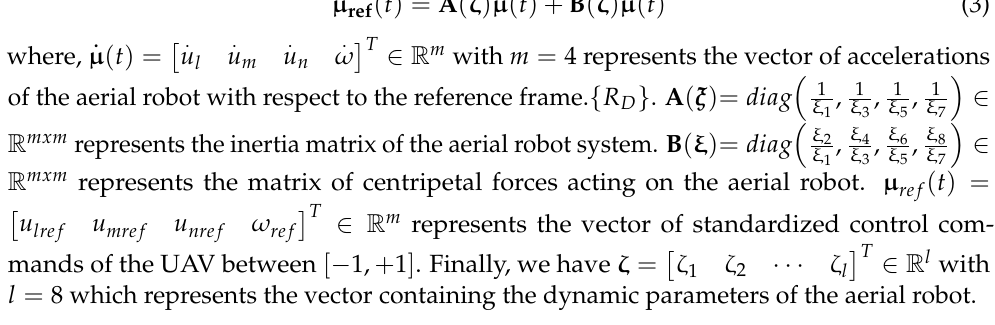
Figure 4. Identification of dynamic parameters. ( a ) Identification scheme; ( b ) Identification data sig- nals. (iii) Validation, the final stage allows us to evaluate whether the dynamic model with the obtained parameters represents the behavior of the hexacopter as it is seen in Figure 5a by using reference signals other than those used in the dynamic parameter identifica- tion process. The values for the dynamic parameters can be seen in Appendix A. ( a )